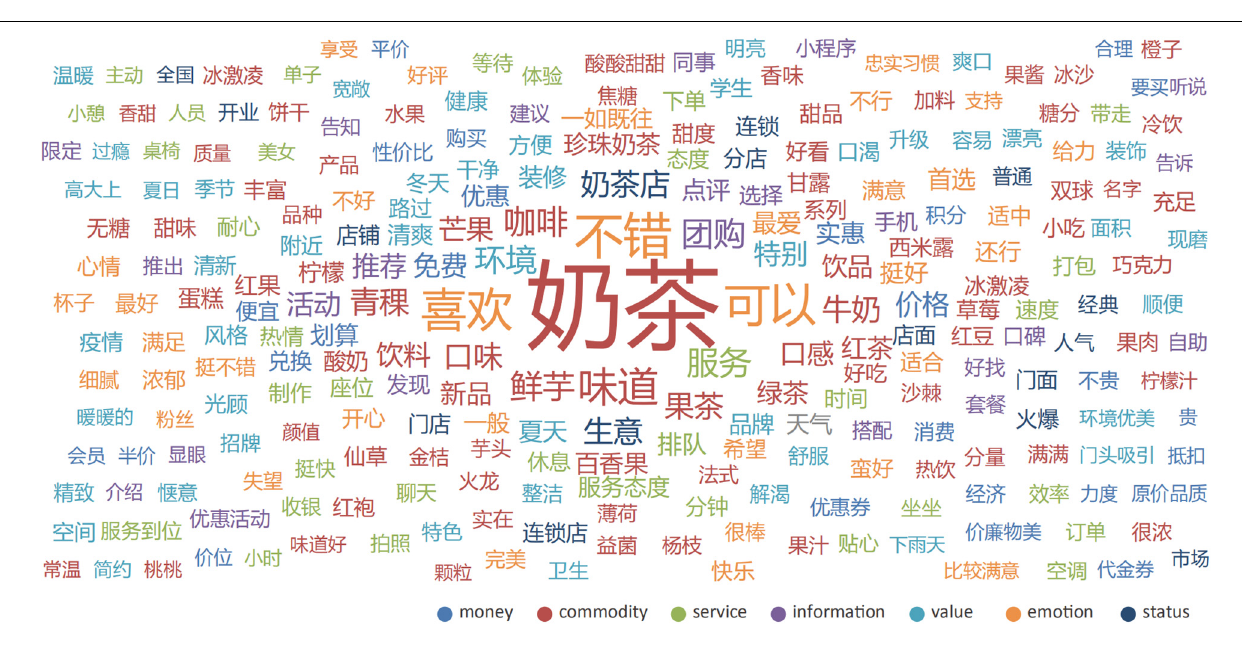
FIGURE 8 | Word frequency statistics cloud